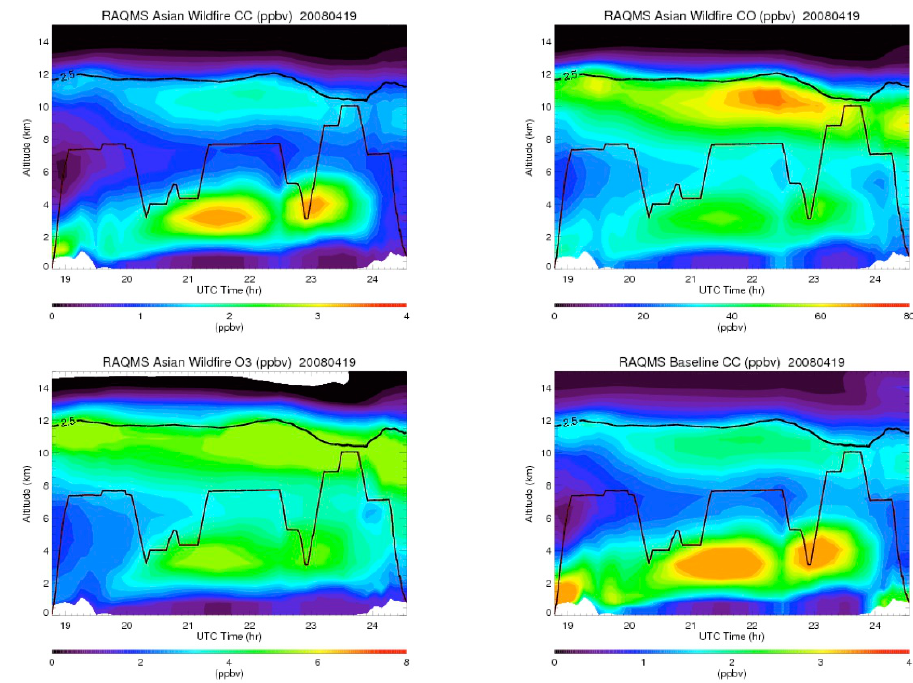
Fig. 13. RAQMS carbonaceous aerosols (CC), carbon monoxide (CO) and ozone (O 3 ) enhancements due to Asian wildfires and RAQMS CC baseline concentration profile (from top left to bottom right) along DC8 flight